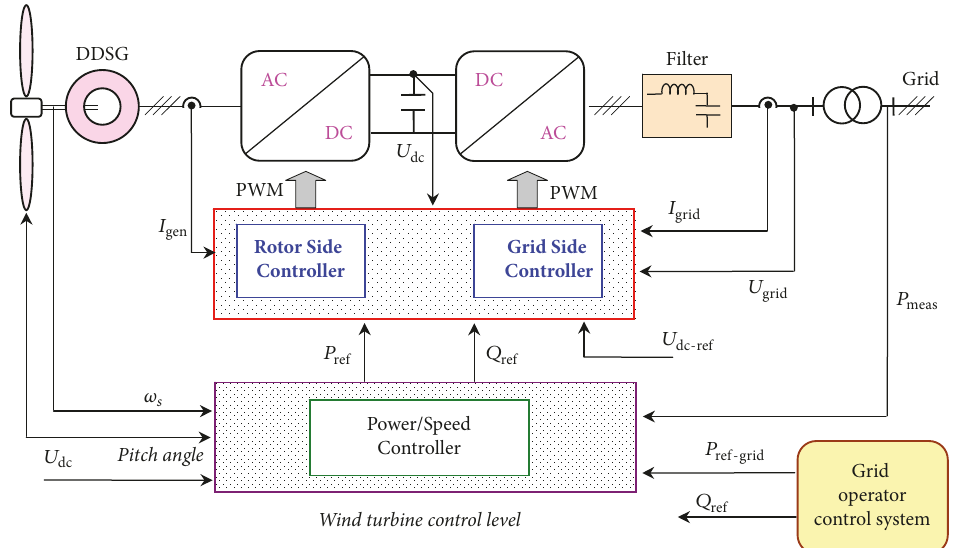
Figure 1: Configuration of a VS-WPGS based